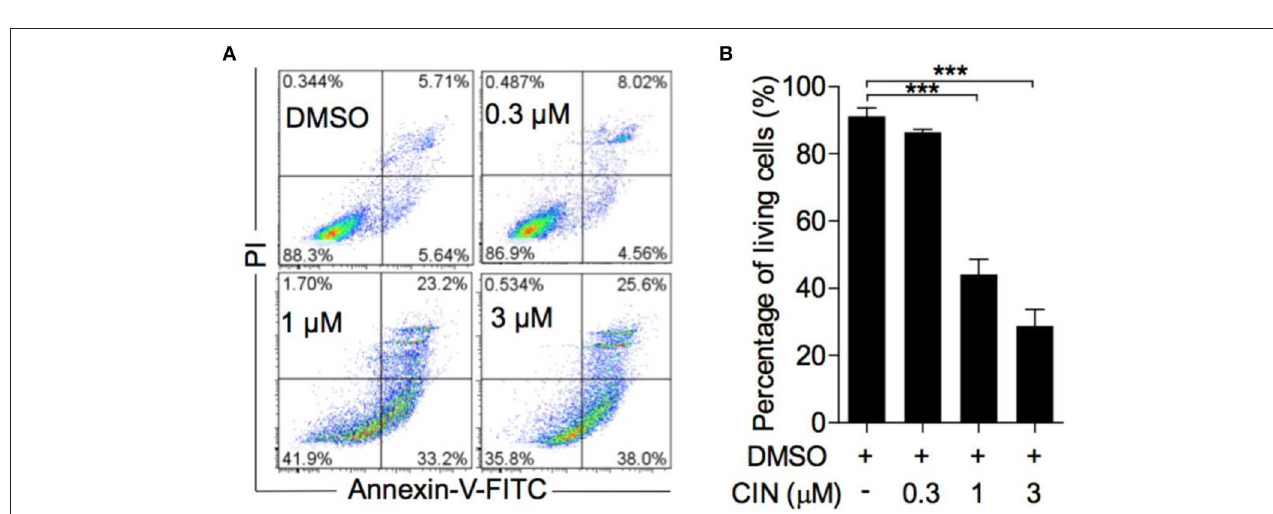
FIGURE 3 | Cinobufagin induces OCM1 cell apoptosis. (A) OCM1 cells were treated with 0, 0.3, 1, and 3 µ M cinobufagin (CBG) for 24h. Then, the cells were stained with Annexin V-FITC/PI and measured by flow cytometry. The living cells were located in the lower left quadrant. (B) Quantification of living OCM1 cells. The results are expressed as the mean ± SEM of three independent experiments [*** P < 0.001 compared with OCM1 cells treated with